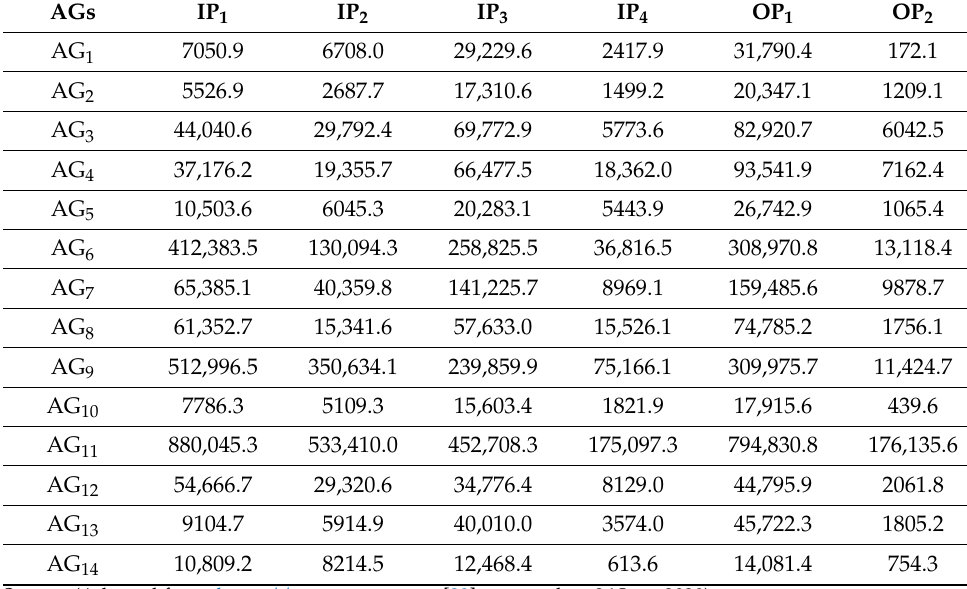
Table 7. Data in 2019 (Unit: 1000